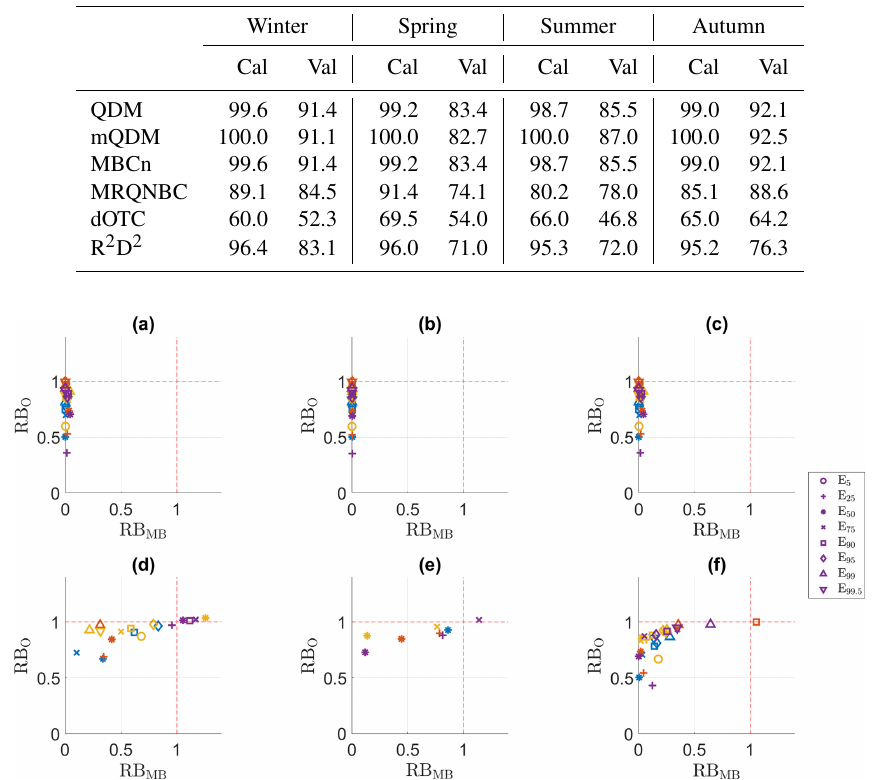
Figure 6. RB MB versus RB 0 for the potential evaporation indices in the calibration period. (a) QDM, (b) mQDM, (c) MBCn, (d) MRQNBC, (e) dOTC, (f) R 2 D 2 . Winter: blue, spring: ochre, summer: yellow, autumn: